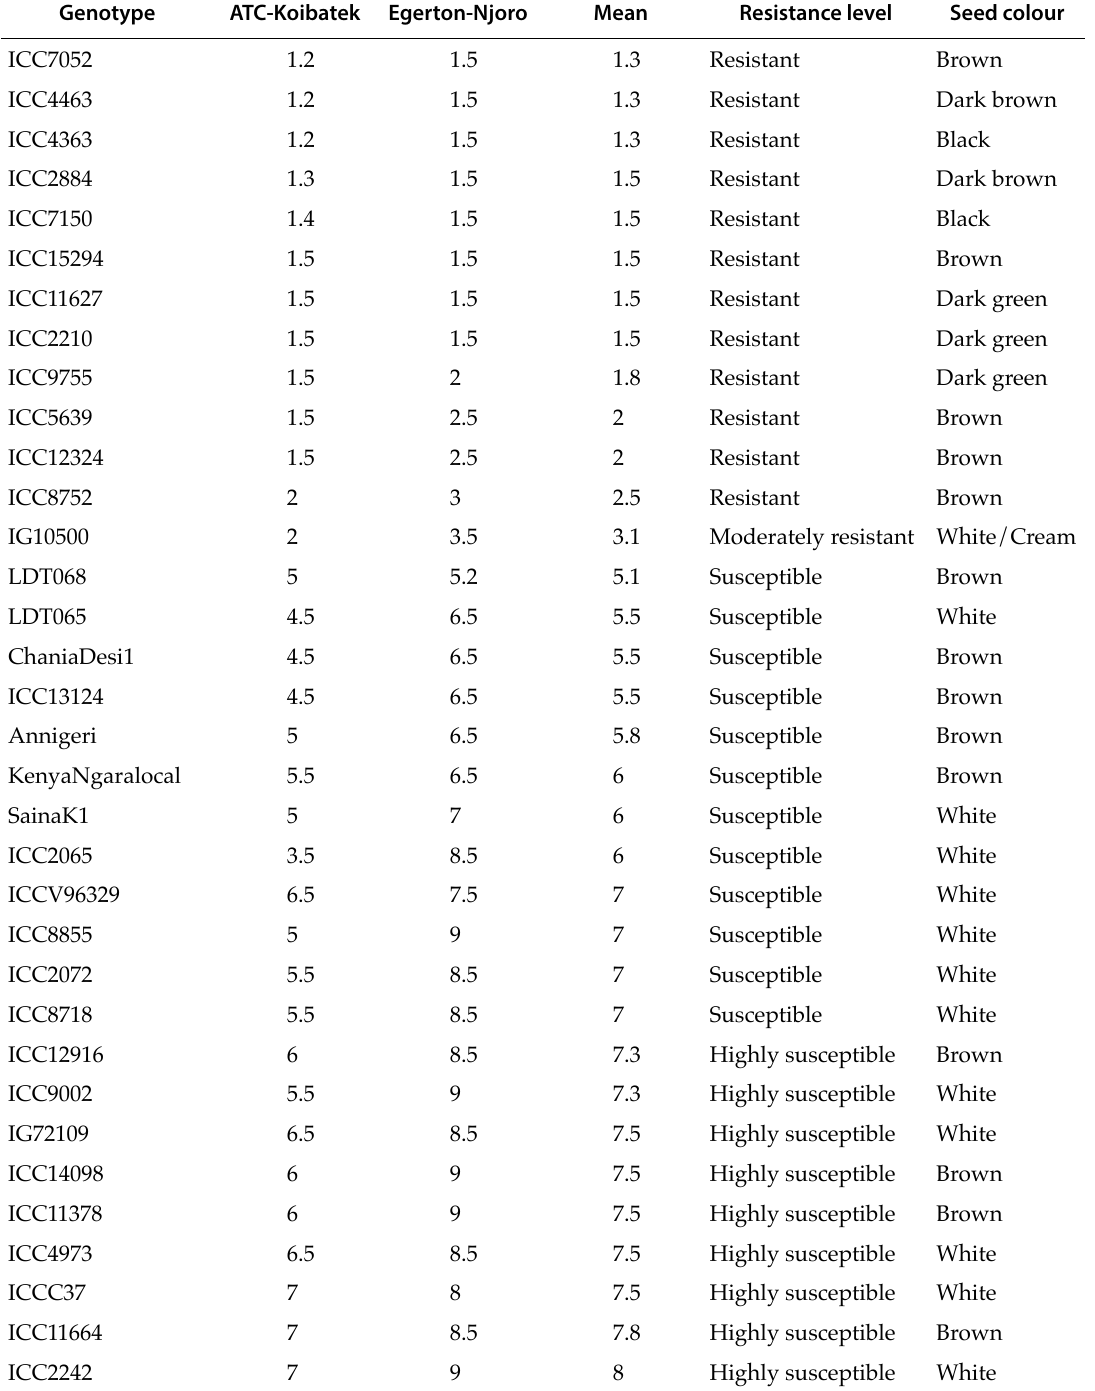
Table 1. Mean Ascochyta blight scores (scale 1‒9 where 1, no disease and 9, dead plants) for 36 test chickpea genotypes in ATC-Koibatek and Egerton-Njoro,